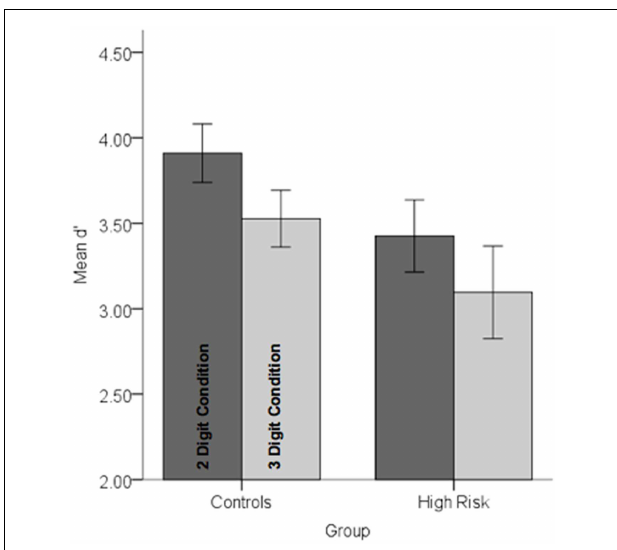
FIGURE 3 | Performance data ( d (cid:48) ) in each of the controls and high-risk groups are depicted for each of the conditions . Note that there was a marginally significant decrement in performance in the high-risk group and a highly significant effect of load (see text for statistical details). Error bars are ± SEM.